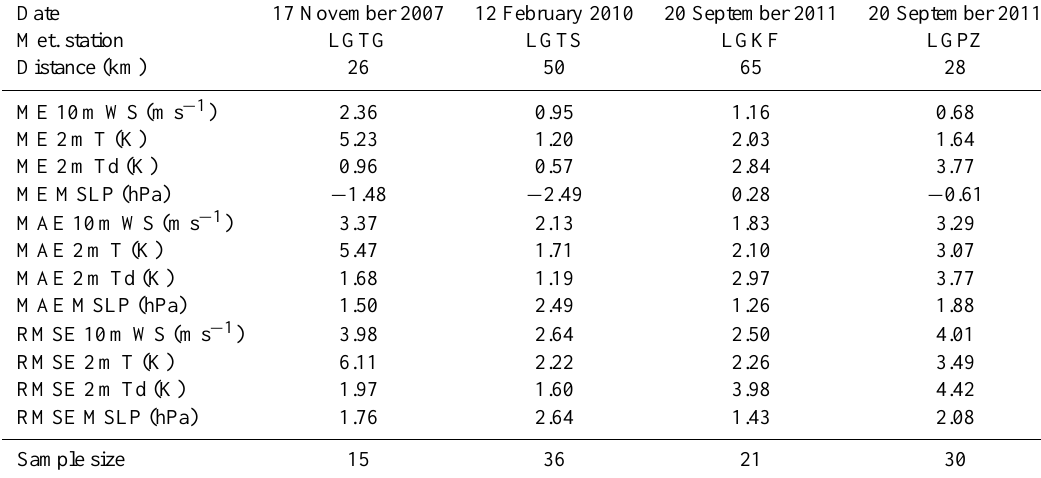
Table 2. Statistical measures of 10m wind speed (WS), 2m temperature ( T ), 2m dew point (Td) and mean sea-level pressure (MSLP) at the meteorological stations of the Hellenic National Meteorological Service at the airports of Tanagra (LGTG), Thessaloniki (LGTS), Cephalonia (LGKF), and Preveza (LGPZ). The model output fields of the D03 grid point closest to each station are used. ME = mean error (WRF-simulated minus observed value), MAE = mean absolute error, RMSE = root mean squared error, sample size = number of valid pairs of simulated and observed values. The date of the model validation and the distance of each station from the location of the corresponding tornado event are also indicated. The spin-up time (first 6h) is not taken into